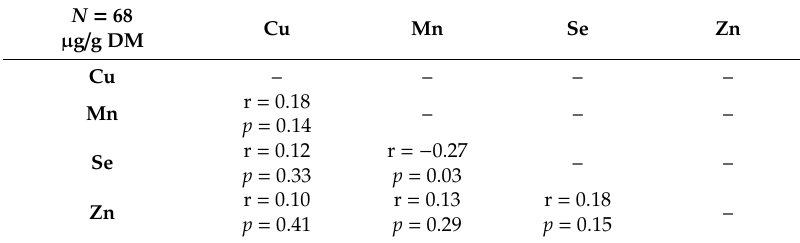
Table 4. Correlation coe ffi cients between the content of Cu, Mn, Se, and Zn in the studied mushrooms. N = 68 µ g / g DM